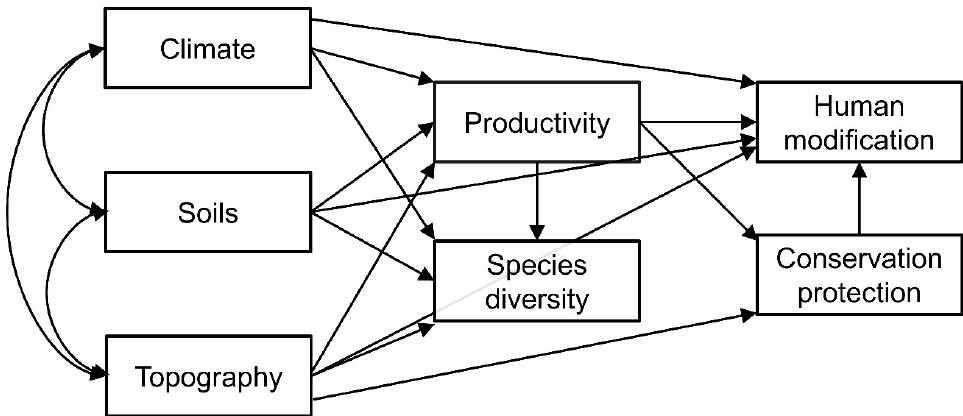
Figure 2. Hypothetical path diagram depicting relationships between climate, soils, topography and their direct or indirect influence on productivity, species diversity (tree richness), the degree of human modification, and conservation protection of United States Department of Agriculture Forest Service (USFS) ranger districts.